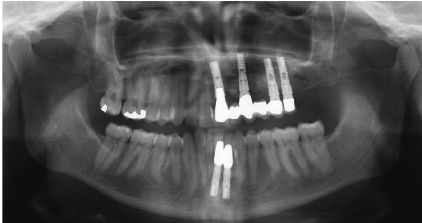
Figure 11: Patient 2: panoramic radiograph (from 2012) taken two years after the last implant had been inserted. The treatment has been performed by Chief Surgeon Nils Worsaae. The radiograph demonstrates that the destruction of teeth caused by virus attack on all left-sided maxillary peripheral nerves (illustrated in Figure 1) and on the left mandibular incisor nerve (marked red in Figure 1) has stopped. Also, the condition around the filling in the left mandibular canine is unchanged since 2004 (Figure 8).